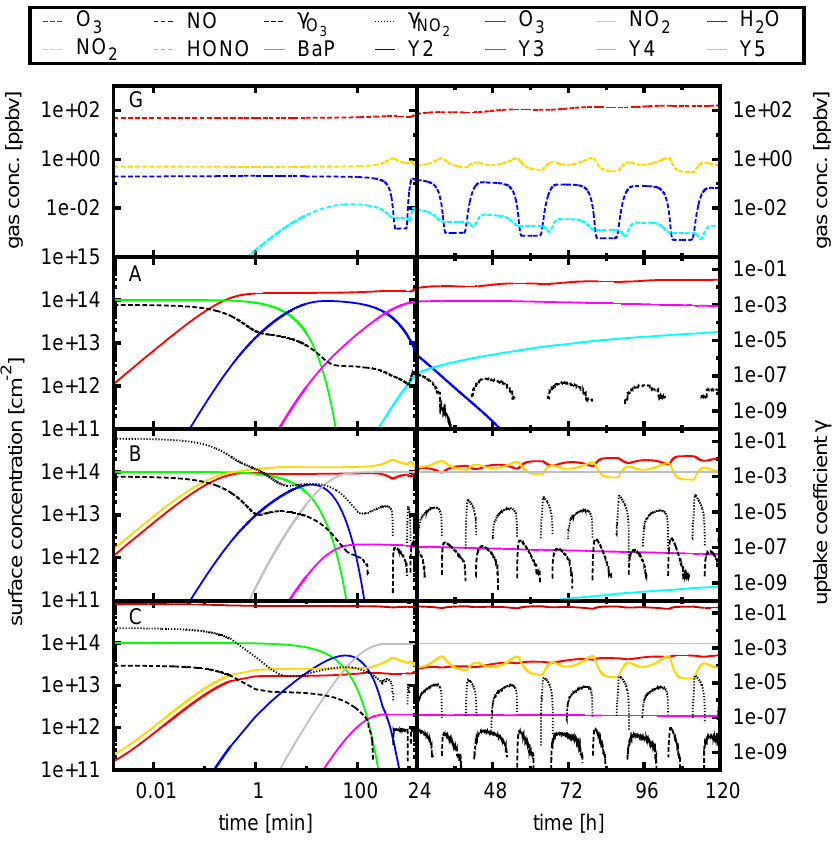
Fig. 2. The temporal evolution of gas-phase component concentrations ( G ), surface component concentrations, and uptake coefficients for the adsorption and surface reaction of O 3 (A) , the co-adsorption of O 3 and NO 2 (B) , and the co-adsorption of O 3 , NO 2 , and H 2 O (C) following the surface reactions defined in Table 1 is plotted on a logarithmic timescale for day one (left panels) and on a linear timescale for the four following days (right panels).